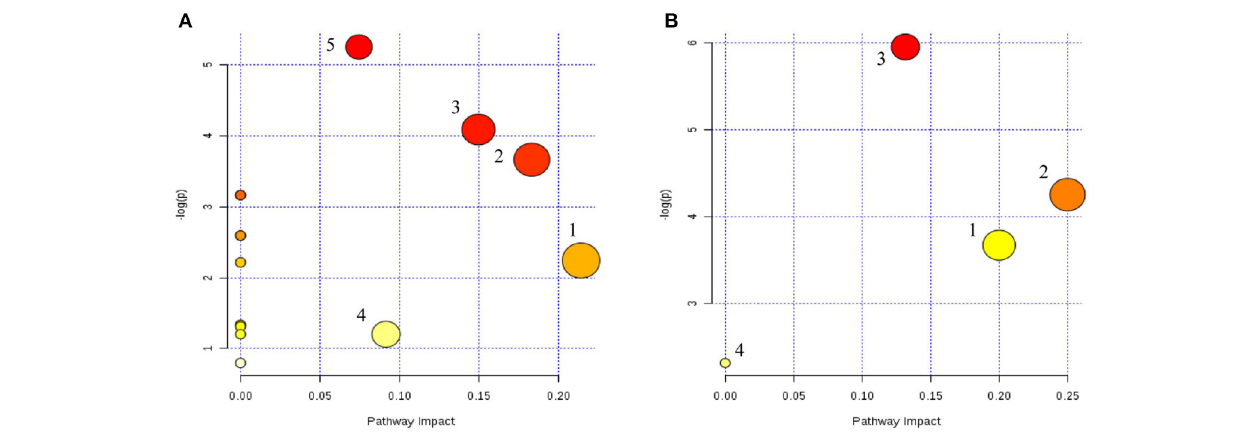
FIGURE 9 | Serum (A) and cerebral cortex (B) differential metabolite-related metabolic pathways. (A) (1) Lipid metabolism; (2) glycerophospholipid metabolism; (3) alanine, aspartate, and glutamate metabolism; (4) tryptophan metabolism; and (5) arginine and proline metabolism. (B) (1) Linoleic acid metabolism; (2) alpha-linoleic